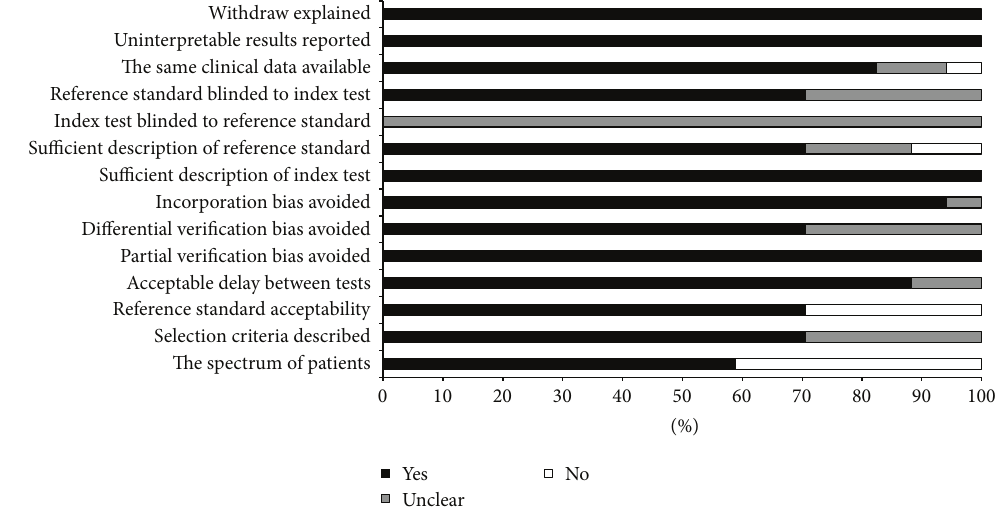
Figure 2: Assessment of the 17 included studies quality with use of the Quality Assessment of Diagnostic Accuracy Studies (QUADAS) tool.